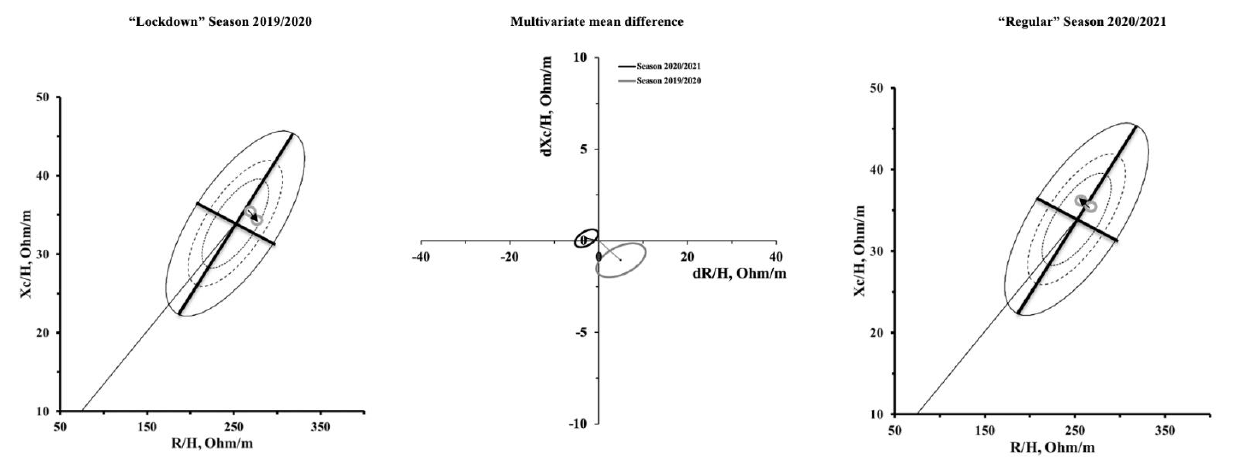
Figure 2. R-Xc and paired graphs for multivariate changes in specific resistance and reactance are shown on the left and right sides. In the R-Xc graphs, bioimpedance data are plotted on the tolerance ellipses of the reference population [9]. In the middle of the figure, mean vector displacements with 95% confidence ellipses are shown.